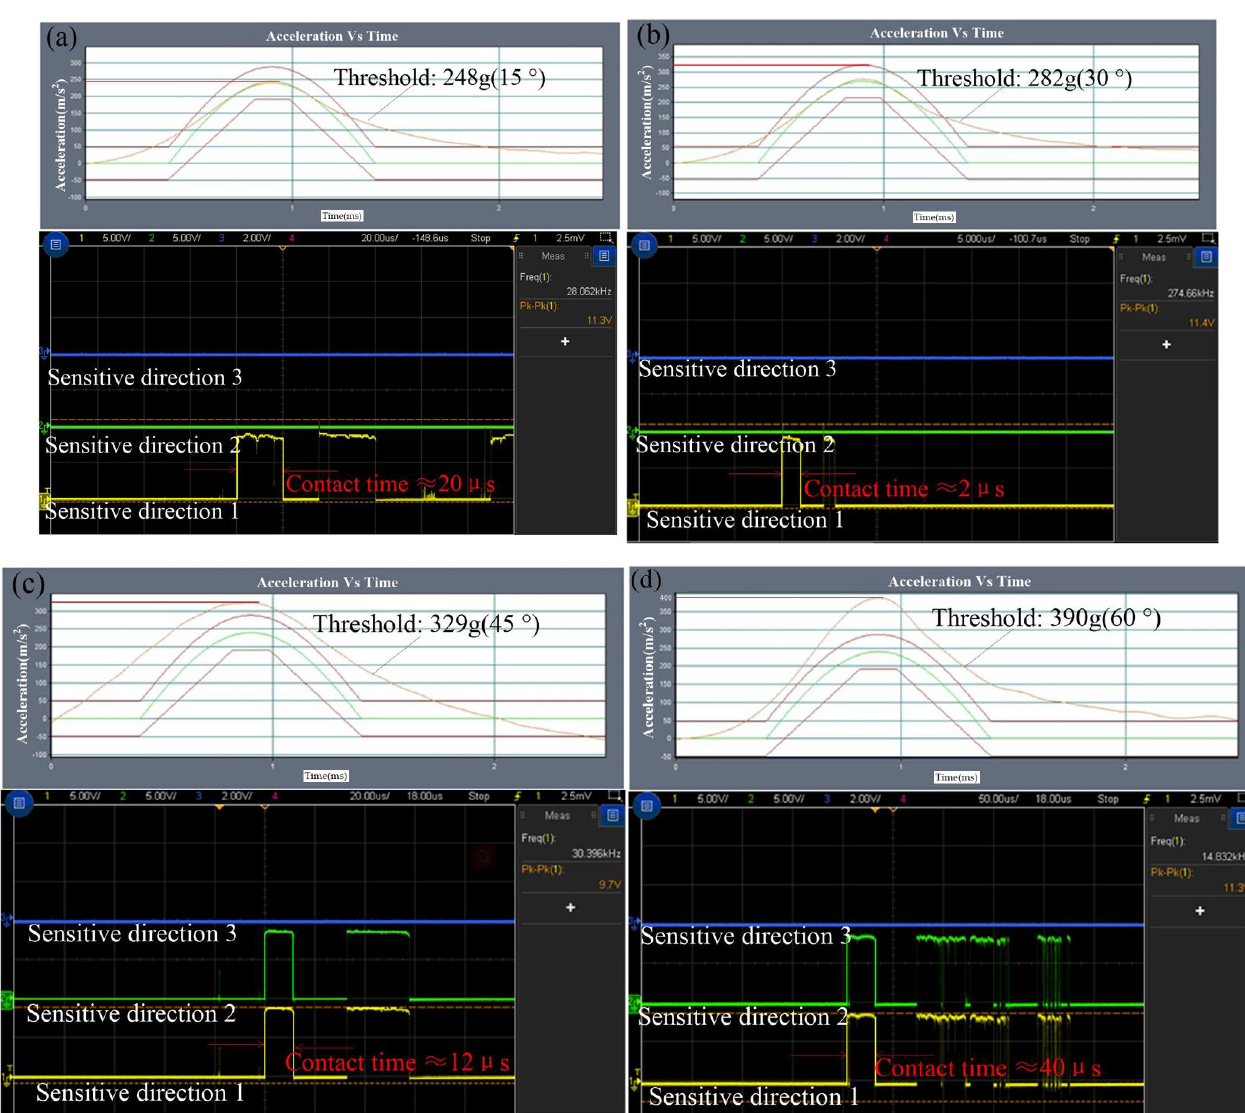
Figure 14. The tested threshold in one of the sensitive directions.